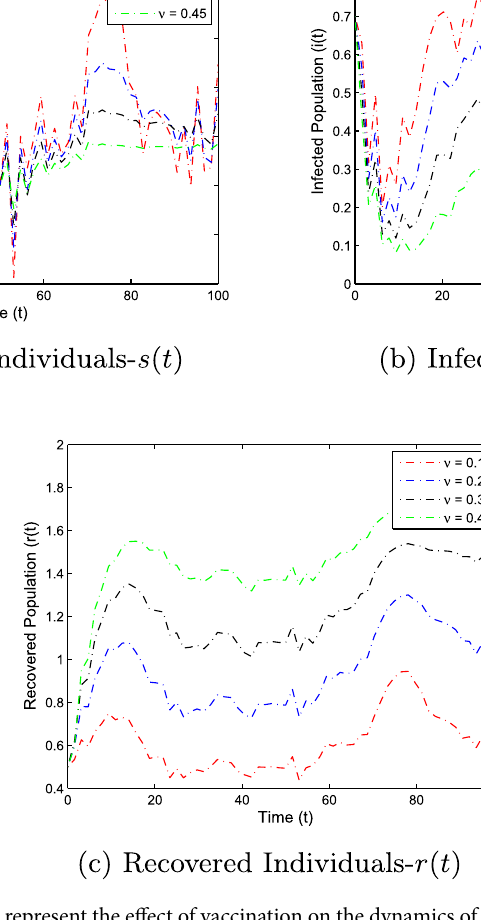
Figure 8. The graphs represent the effect of vaccination on the dynamics of various compartments in case of the persistence analysis of the model